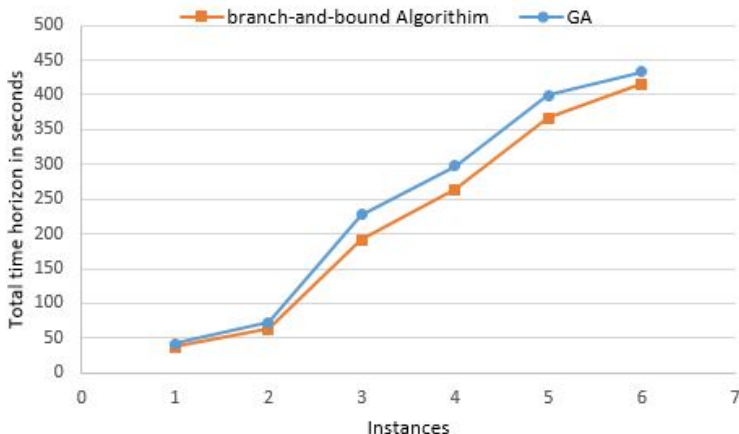
Figure 4. Comparative plots in between computational time and number of instances.